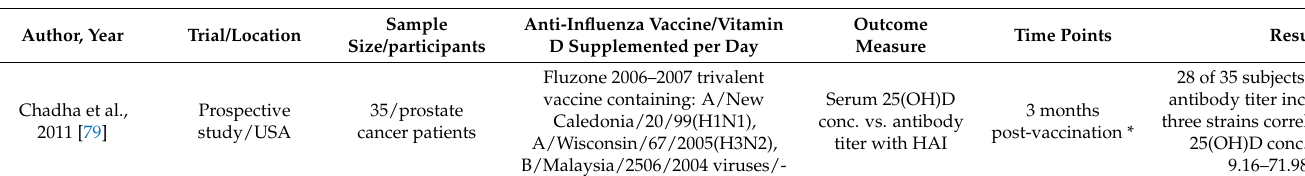
Table 2. Results of human studies on the association between vitamin D serum level and the serological response to anti-influenza vaccines published between the years 2011 and